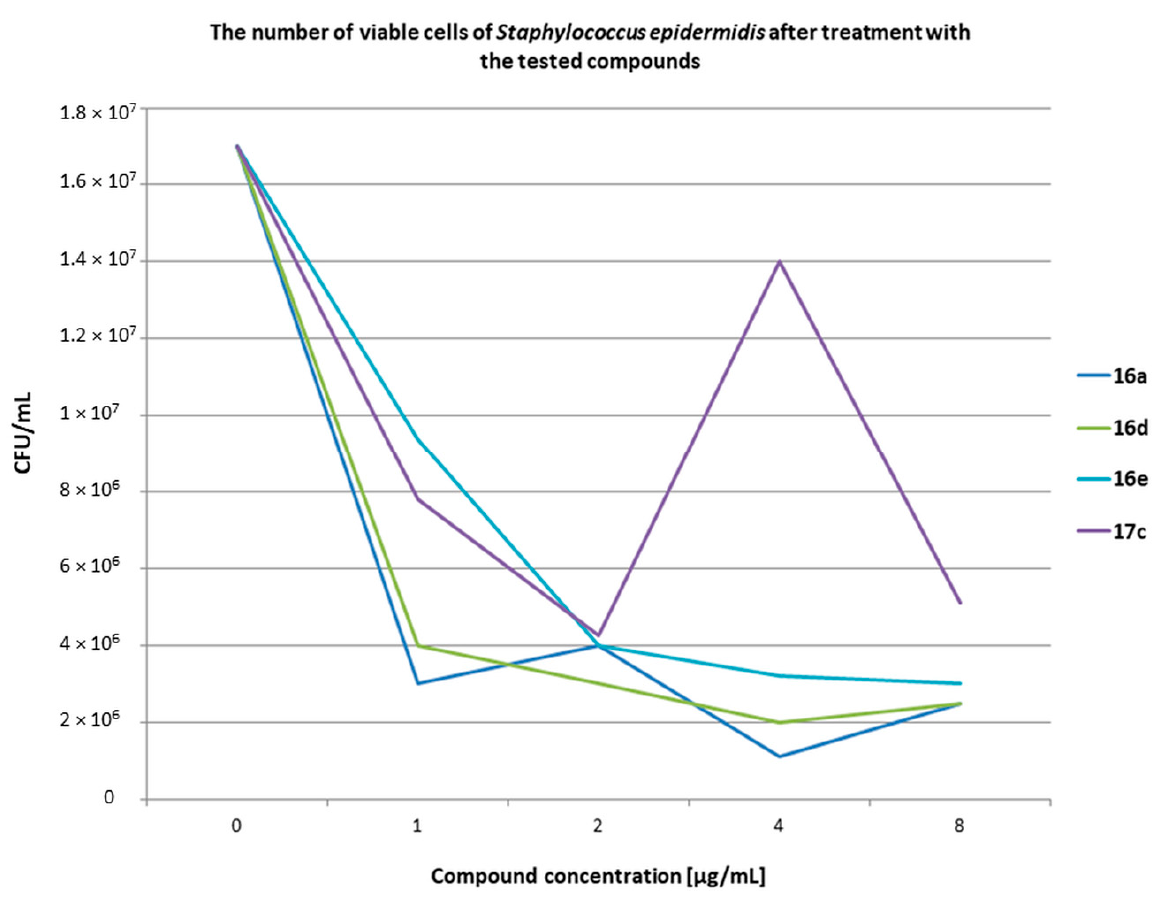
Figure 9. The results of the measurement of the number of viable cells of S. epidermidis after treatment with the tested compounds at various concentrations. t 0 1.70 × 10 7 ; t 24 5.10 × 10 8 . Table 3. The results of the measurement of the number of viable cells of Staphylococcus epidermidis after the action of the tested compounds at various